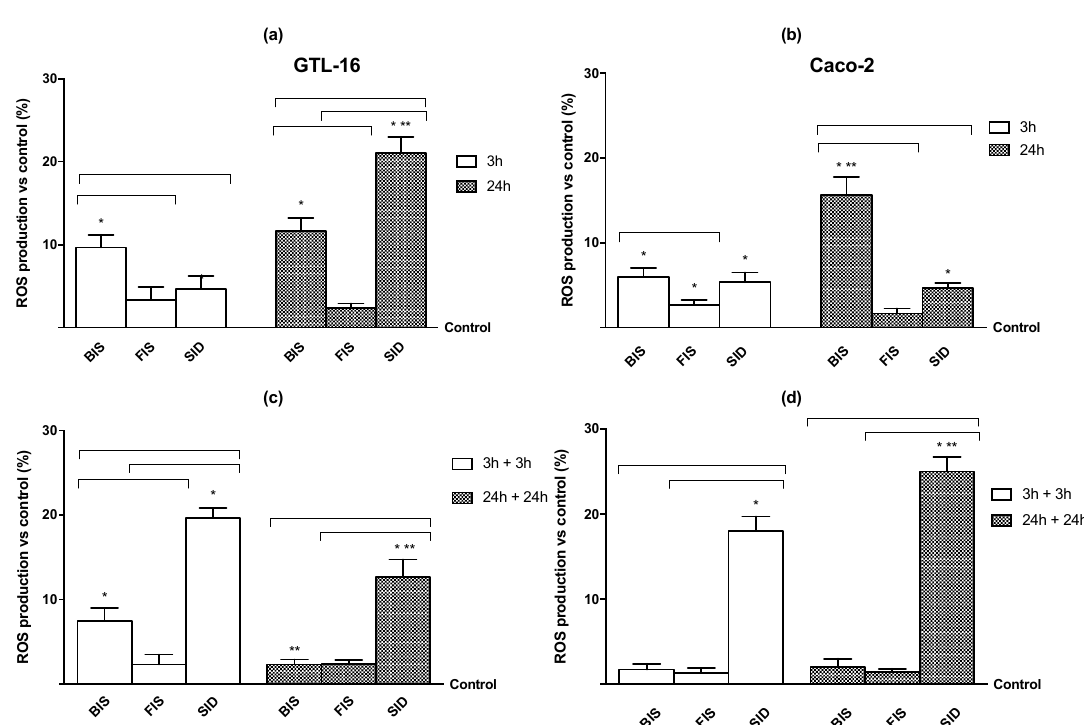
Figure A3. Radical oxygen species (ROS) measurements on GTL-16 ( a , c ) and Caco-2 ( b , d ) cells treated with different iron formulations at 3 h and 3 h plus 3 h or 24 h and 24 h plus 24 h. The results are expressed as means ± SD of four independent experiments for each cell type. * p < 0.05 vs. control; ** p < 0.05 vs. correspondent column at different time; bars p < 0.05 among different treatment at the same time.